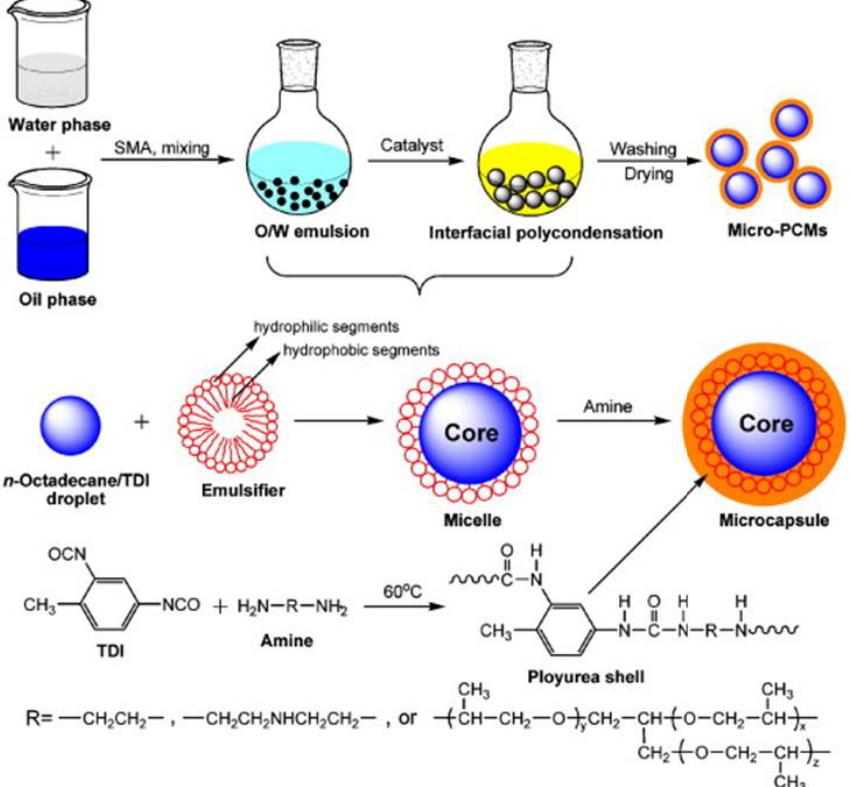
Figure 11. Schematic of microencapsulation process of n -octadecane with poly-urea shells [106].